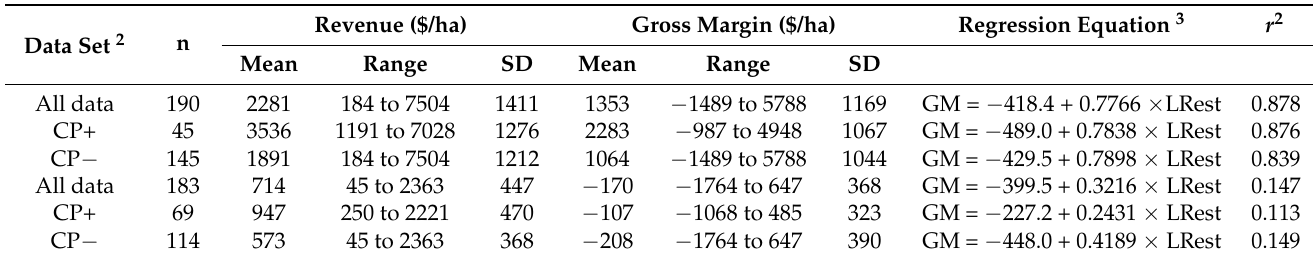
Table 3. Revenue, gross margins, and relationship between revenue and gross margin for cereal and cereal/vetch crops based on estimated value of liveweight production and estimated crop costs of production 1